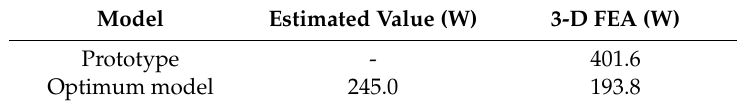
Table 6. Comparison of eddy current loss inside PMs according to calculation